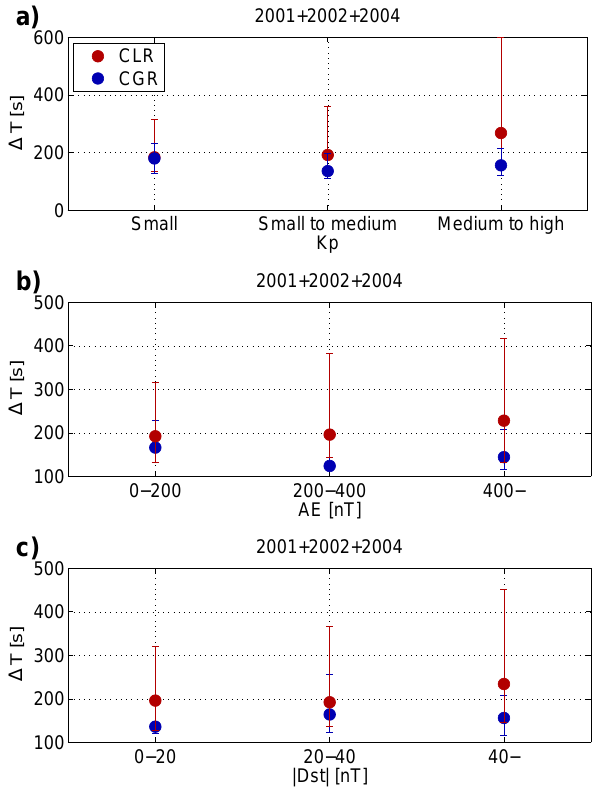
Fig. 7. Variation of the lifetime of ECRs as a function Kp (a), AE (b), and Dst (c).